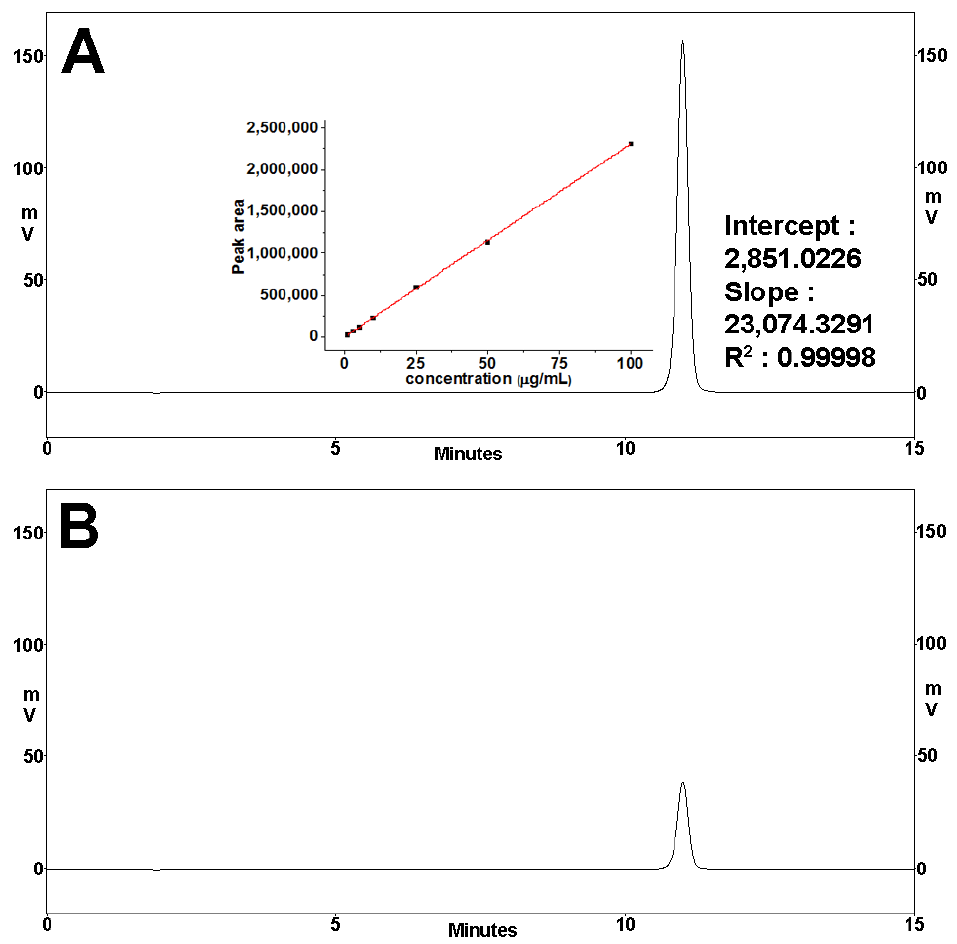
Figure 6. ( A ) HPLC spectrum of a representative diclofenac sodium calibration standard: concentration 100 µ g/mL and fitting parameters of the respective calibration curve; ( B ) HPLC spectrum of a representative sample analysis during release experiments.